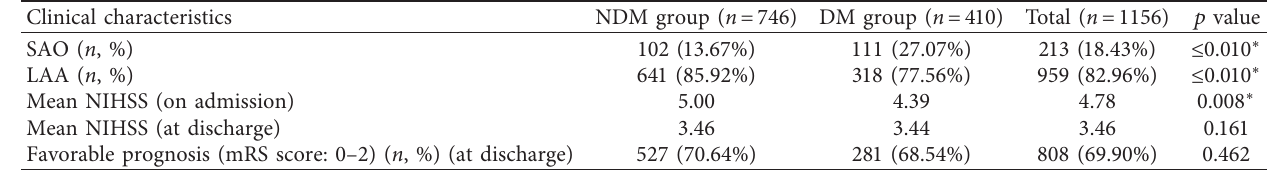
Table 2: Classification of etiology and prognosis at discharge of the participants.